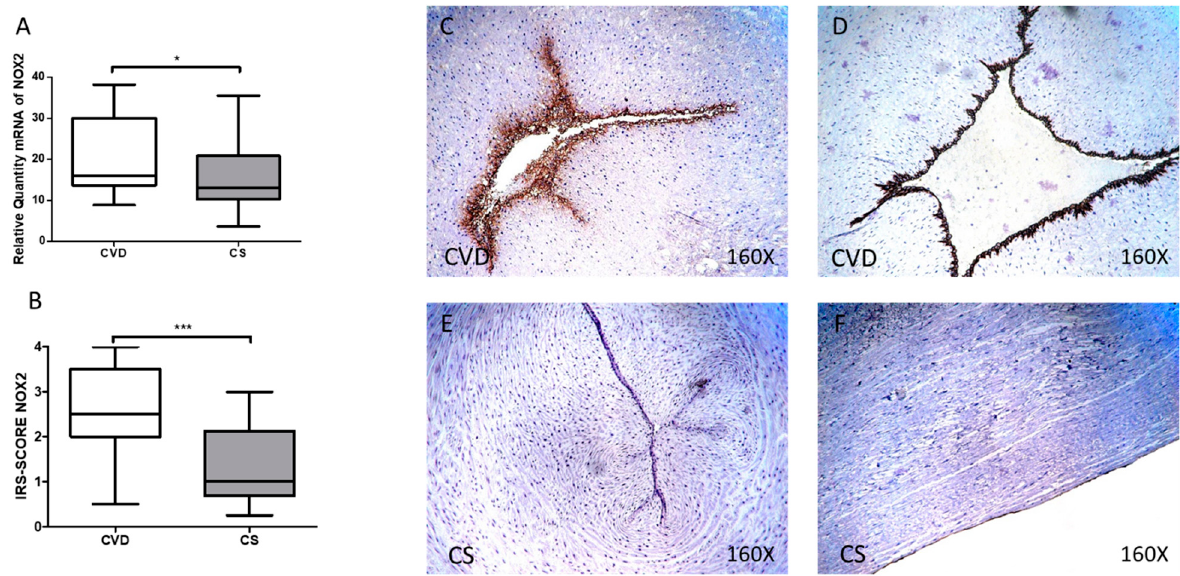
Figure 3. ( A ) mRNA expression levels for NOX2 by RT-qPCR in the umbilical cord. ( B ) Levels of IRS-Score quantification in the umbilical cord. ( C – F ) Images showing the immunoexpression of NOX2 in the umbilical cord. CVD = Newborns of women diagnosed with chronic venous disease during pregnancy. CS = Control without venous pathology. p < 0.05 (*) and p < 0.001 (***).